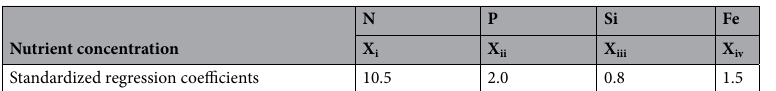
Table 8. The standardized regression coefficients of the growth model as affected by the nutrient concentrations.